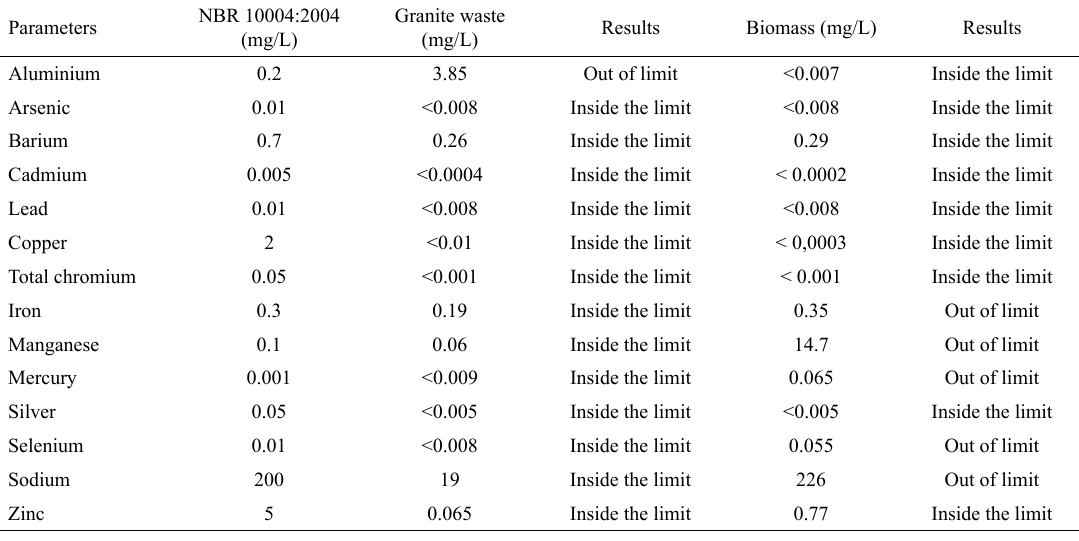
Table 5. Analytical results of the solubilization extract.